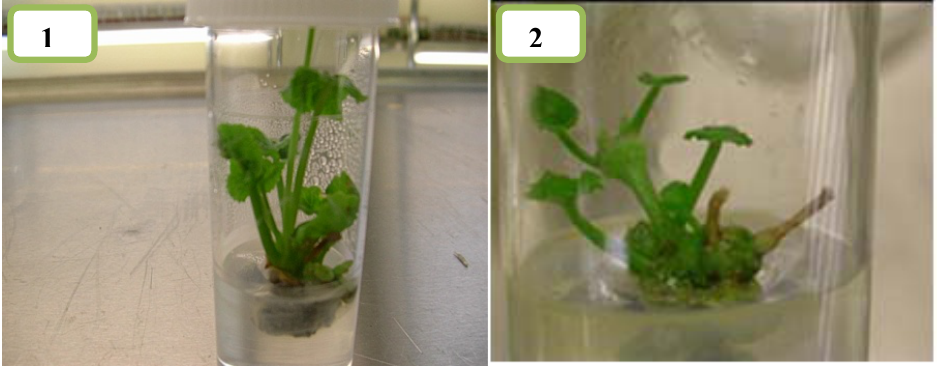
Figure 5. Shoot regeneration in MS (1) and Duchefa shoot medium (2) supplemented with (B2N0.1) in C.asiatica after 3